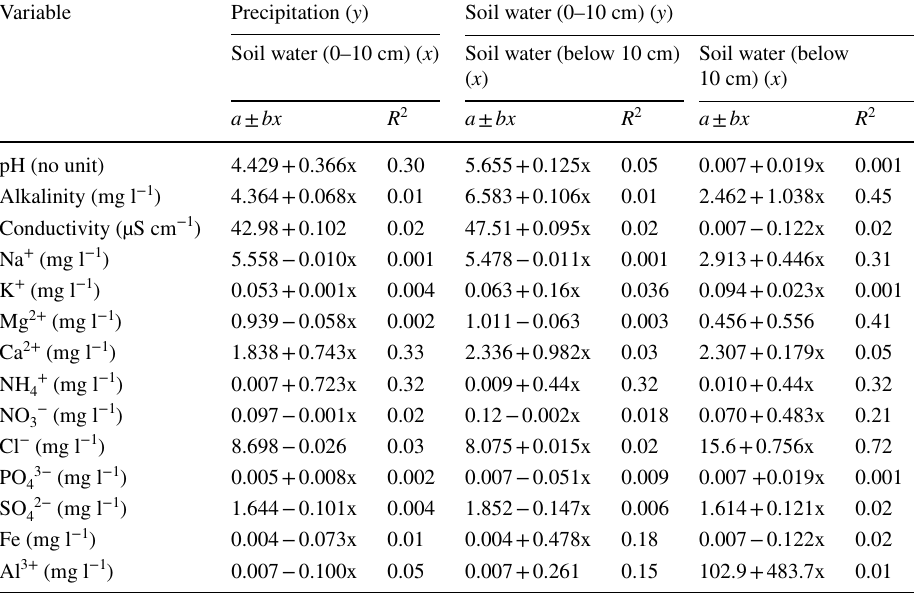
Table 3 Linear regression ( y = a ± bx ) in between the precipitation and soil water chemistry